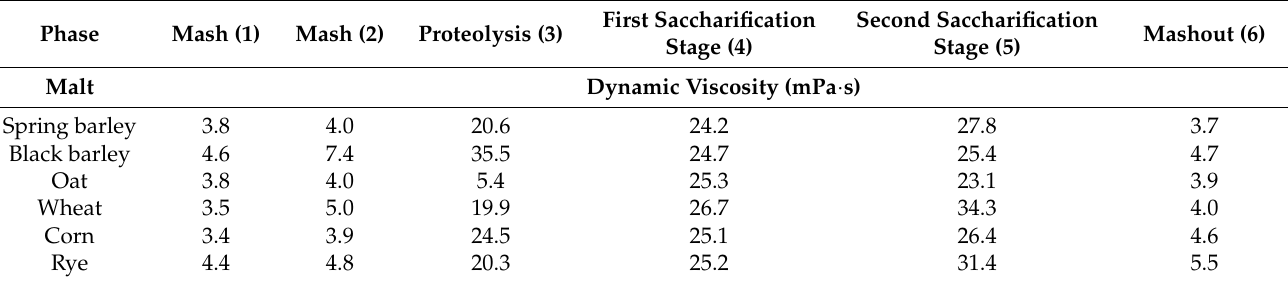
Table 4. Means of dynamic viscosity measurement